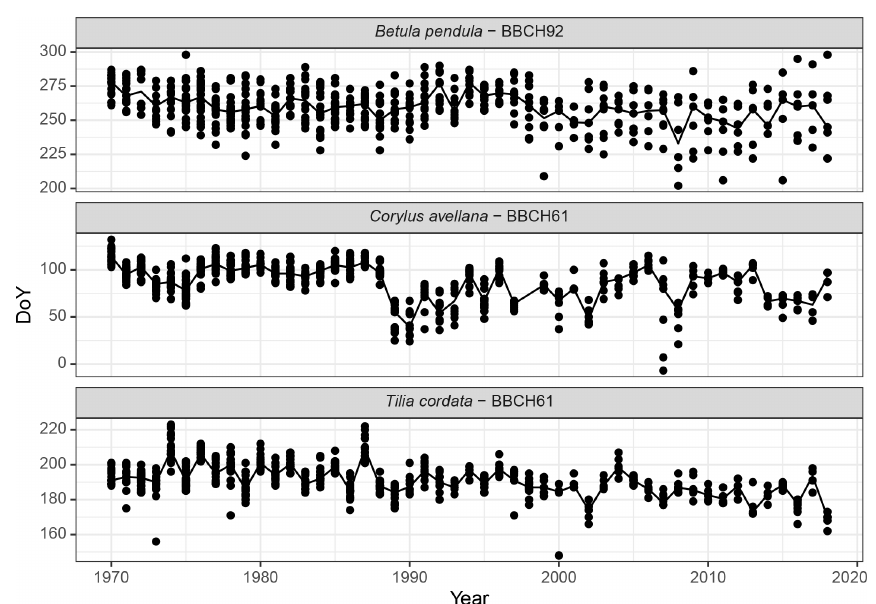
Figure 8. Long-term and annual phenological changes in Latvia: examples of the beginning of the flowering of hazel ( Corylus avellana , BBCH61) and linden ( Tilia cordata , BBCH61) and yellowing of the leaves of silver birch ( Betula pendula , BBCH92) from 1970 to 2018; all available observation data of the given phases are